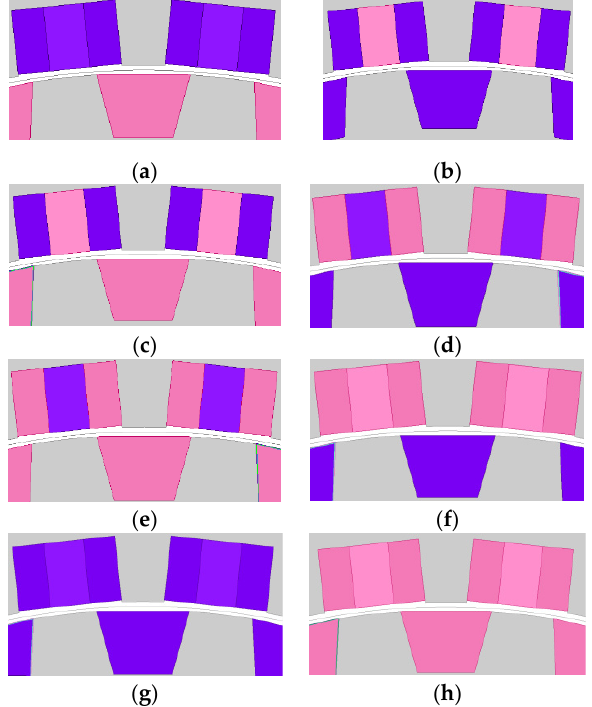
Figure 4. Combinations of NdFeB and ferrite PMs. ( a ) Type 1. ( b ) Type 2. ( c ) Type 3. ( d ) Type 4. ( e ) Type 5. ( f ) Type 6. ( g ) Type 7. ( h ) Type 8.